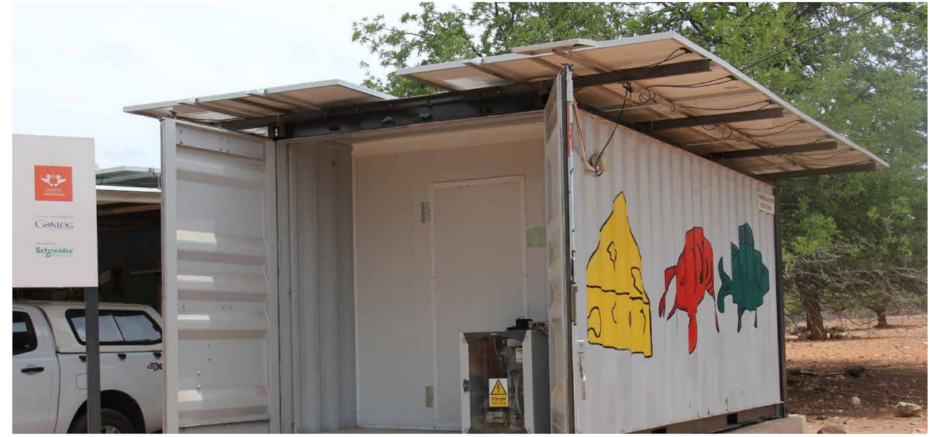
Figure 1. Gwakwani village PV-powered cold